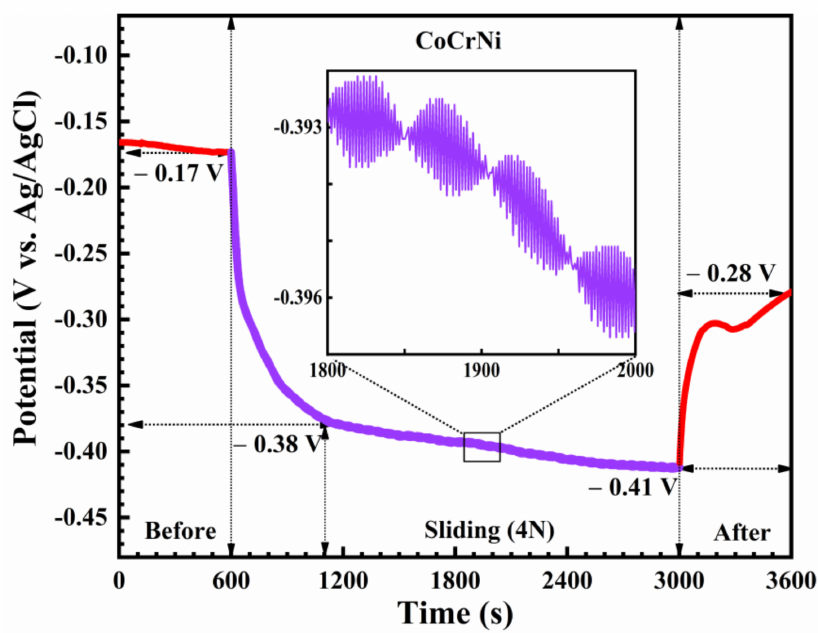
Figure 2. OCP curve of CoCrNi before (10 min), during (40 min), and after (10 min) rubbing with Si 3 N 4 at 4 N normal loads. The insert map is the enlarged view presenting the details of the OCP